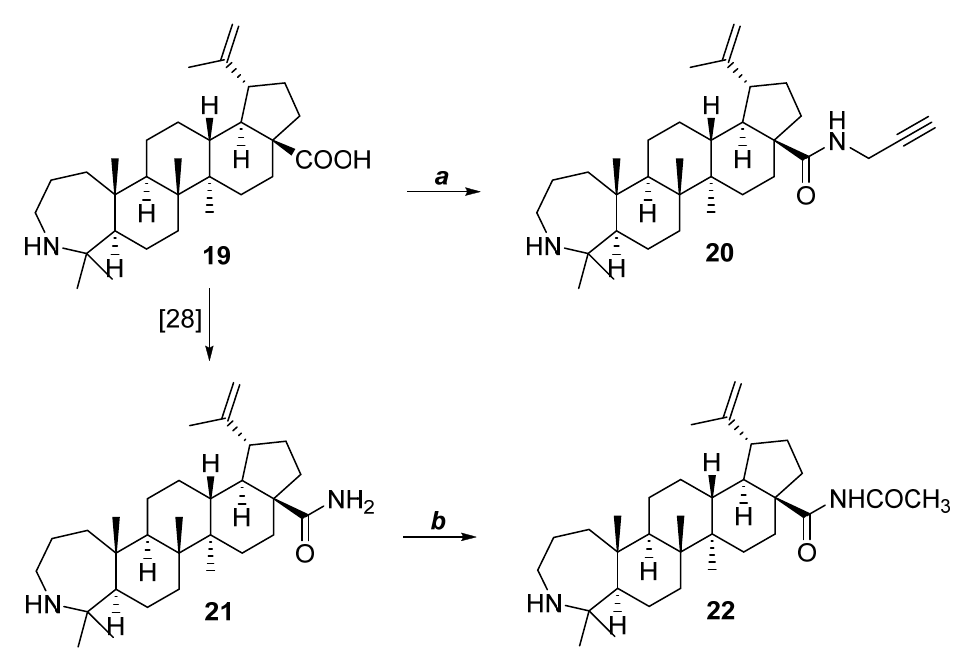
Table 1. The predicted label for each of tested compound ( i.e ., 0 means lack of anti-TB activity, and 1 means anti-TB ac- tivity), using K-Means, Linear Regression, K-Nearest Neighbors, Random Forest, SVC, Linear SVC, and MLP machine learning algorithms. The last column presents the average label value, representing the aggregated score. Compounds with a 0.5 lower aggregated score are highlighted in